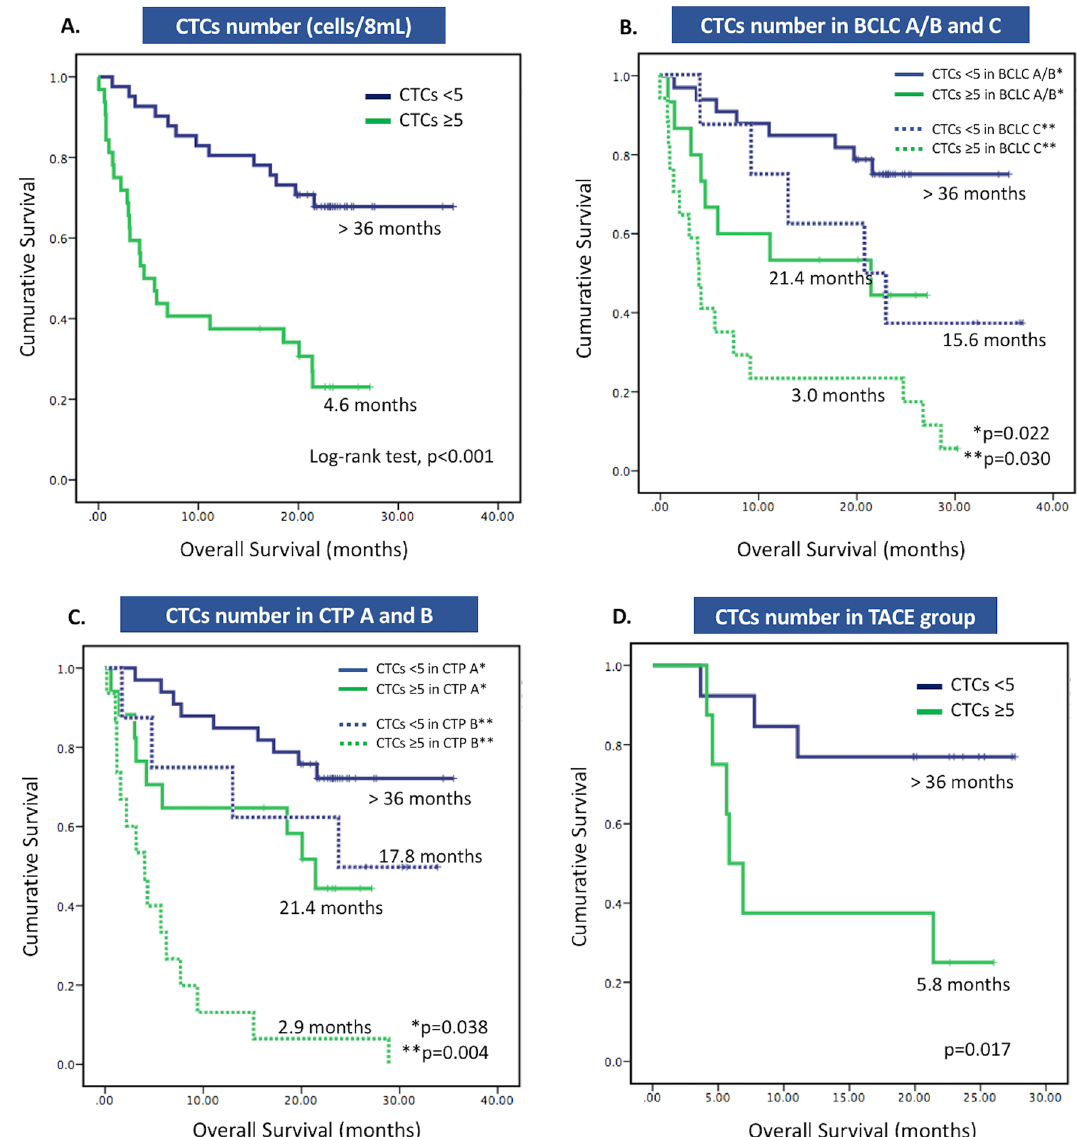
Figure 3. Survival of HCC patients classified by the number of CTCs ( A ), BCLC stages ( B ), and Child- Turcotte-Pugh (CTP) classes ( C ), and survival of HCC patients treated with TACE ( D